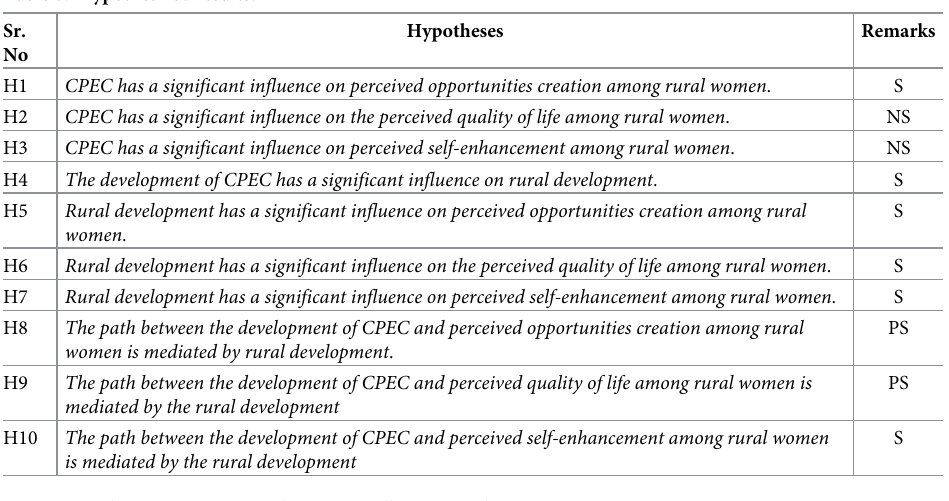
Table 6. Hypothesized